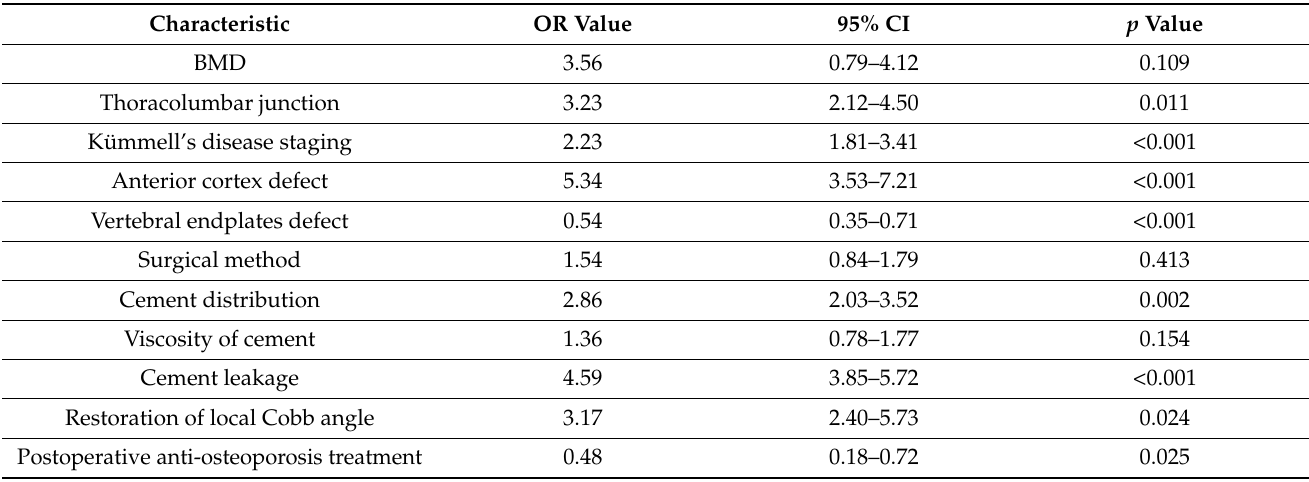
Table 3. Binary logistic regression correlation analysis for risk factors of bone cement displacement following PVA in Kümmell’s